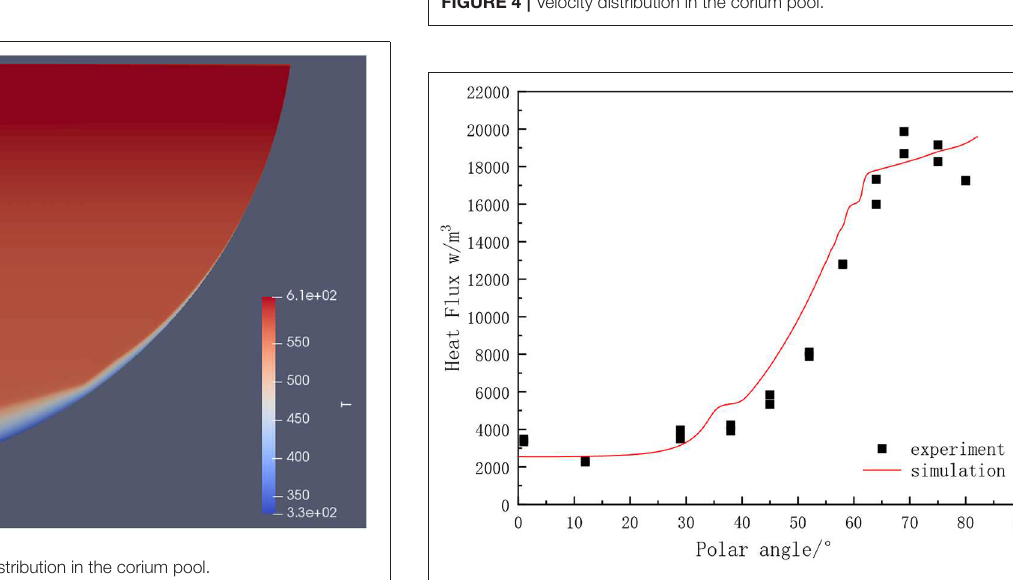
FIGURE 4 | Velocity distribution in the corium pool.